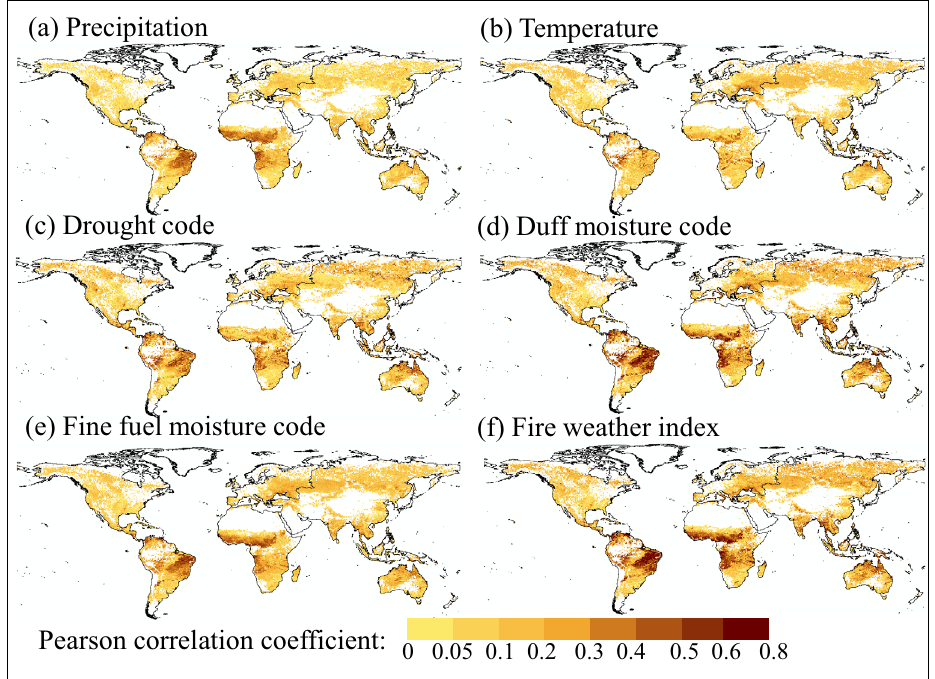
Fig. 2 Pearson correlation coefficient plot of wildfire-related variables and burned area. The blank area in this figure is the area without any wildfire data. This figure shows the spatial distribution of correlation coefficients between six wildfire-relatedvariables and burned area from 2001 to